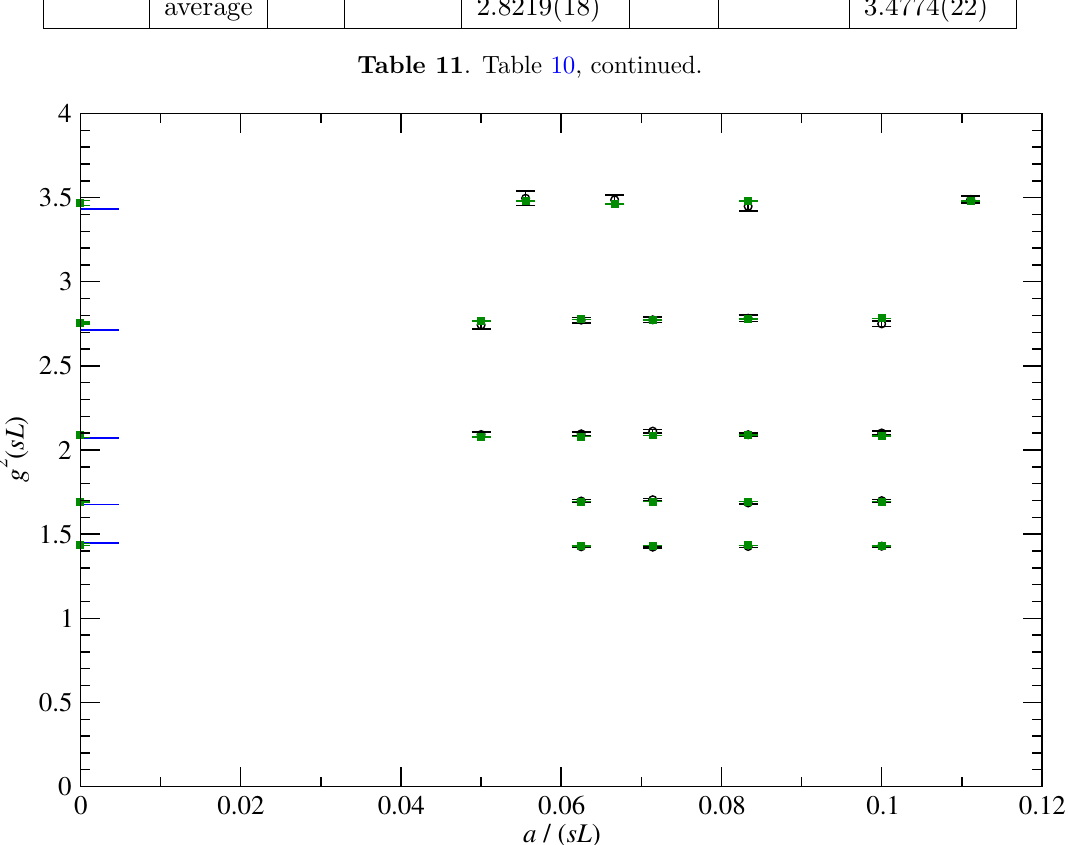
Figure 6 . Squared SU(3) couplings evaluated at sL (green squares) for (cid:12)ve di(cid:11)erent values of g 2 ( L ) (from bottom to top: g 2 ( L ) = 1 : 2571(32), 1 : 4252(34), 1 : 6943(47), 2 : 0902(51), and 2 : 793(17)) and for s = 2 in all cases except for g 2 ( L ) = 2 : 793(17), for which s = 3 = 2. The data are plotted against a= ( sL ). On the vertical axis, the continuum-extrapolated values (green symbols) are compared with the two-loop predictions (horizontal blue segments). The (cid:12)gure also displays the results from ref. [32] as black circles.